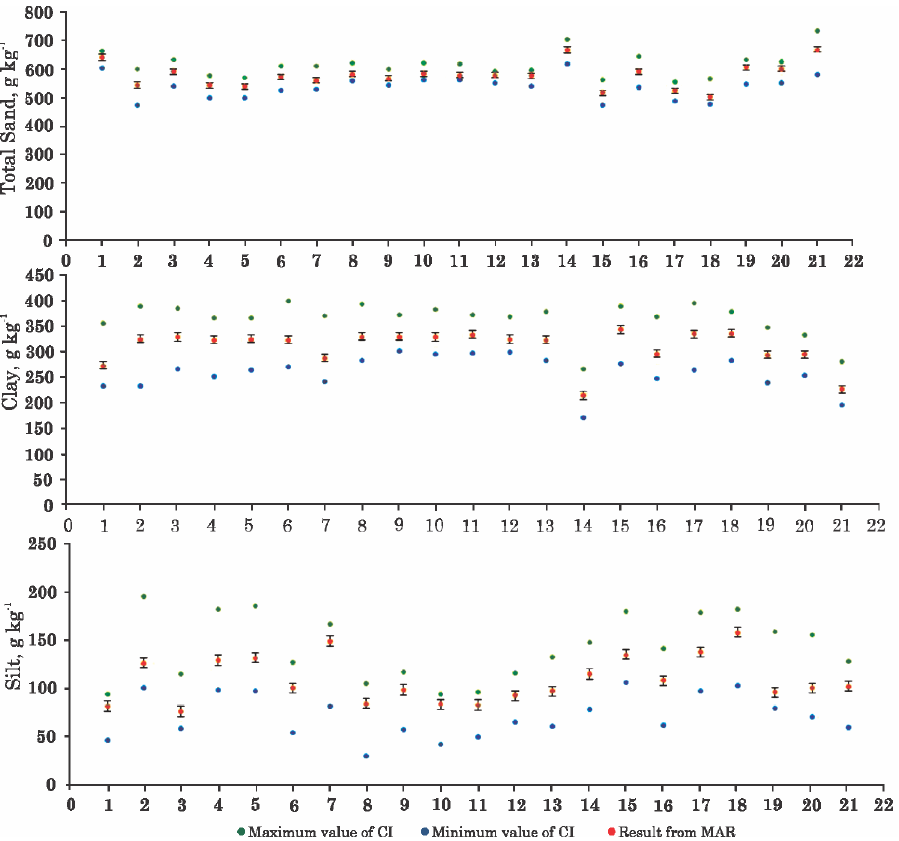
Figure 2. Accuracy analysis of nine sandy soil samples: representation of the minimum and maximum values of the confidence intervals (CI), means and average standard errors (bars) for total sand, silt and clay contents as determined by particle-size analysis using the reciprocal shaker